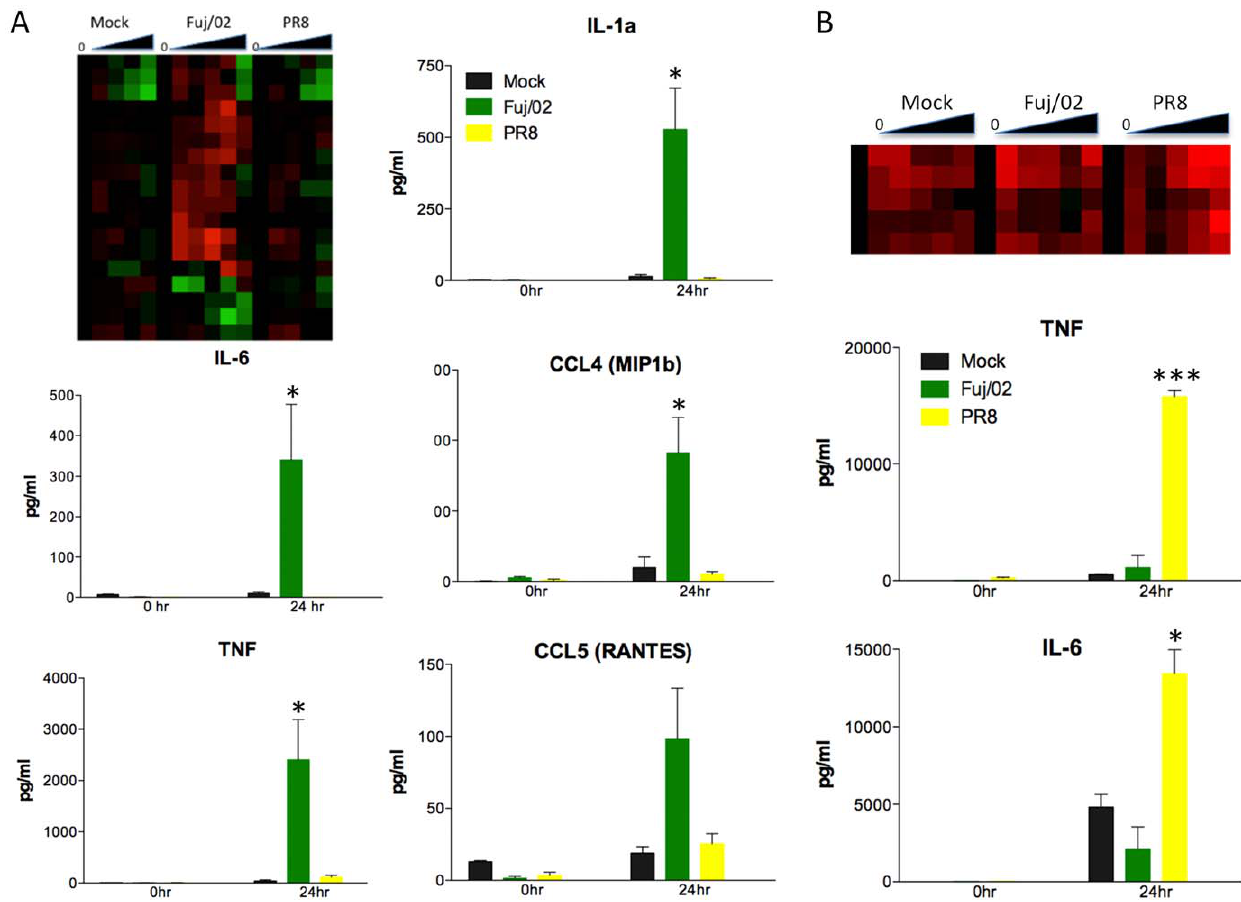
Figure 5. AM do not respond to exposure lethal influenza A flu viruses. (A) Heatmap of immune response gene expression profile of murine AM exposed to Fuj/02 or PR8. The response elicited by PR8 is indistinguishable from that seen following mock infection. Luminex analysis of cytokines (IL-1 a , IL-6 and TNF) and chemokines (CCL4 and CCL5) present in supernatants collected at 0 and 24 hours post exposure to Fuj/02 and PR8. No cytokines are detected in SNs from cells exposed to PR8 but robust production is seen when cells are exposed to Fuj/02. Results shown are mean 6 SE of 3–8 independent experiments. (B) Heatmap of cytokine and chemokines gene expression profile of macaque AM exposed to Fuj/02 or PR8. Both mock and Fuj/02 infection exhibit transient activation of these cytokines, whereas PR8 exposure induces sustained expression. Luminex analysis of TNF and IL-6 levels confirms the increased production cytokine following PR8 exposure. Results shown are mean 6 SEM of 3 independent experiments. Statistics were performed using one-way ANOVA with a Tukey post test. P values * , 0.05, *** ,